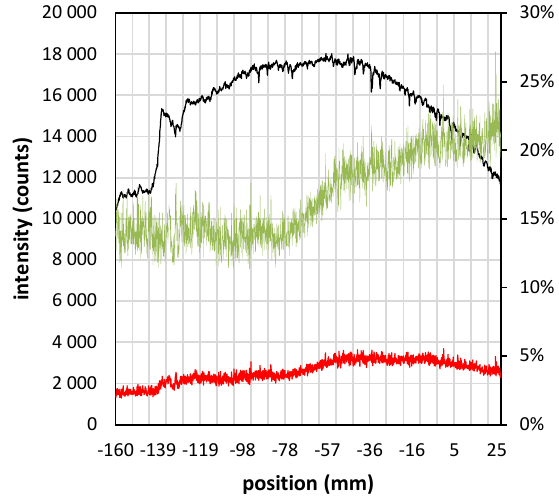
Fig. 4. Intensity along horizontal channel centreline. The upper black curve : average image intensity; the lower red curve: difference between the maximum and minimum of intensity fluctuation; central green curve: percentage deviation on secondary